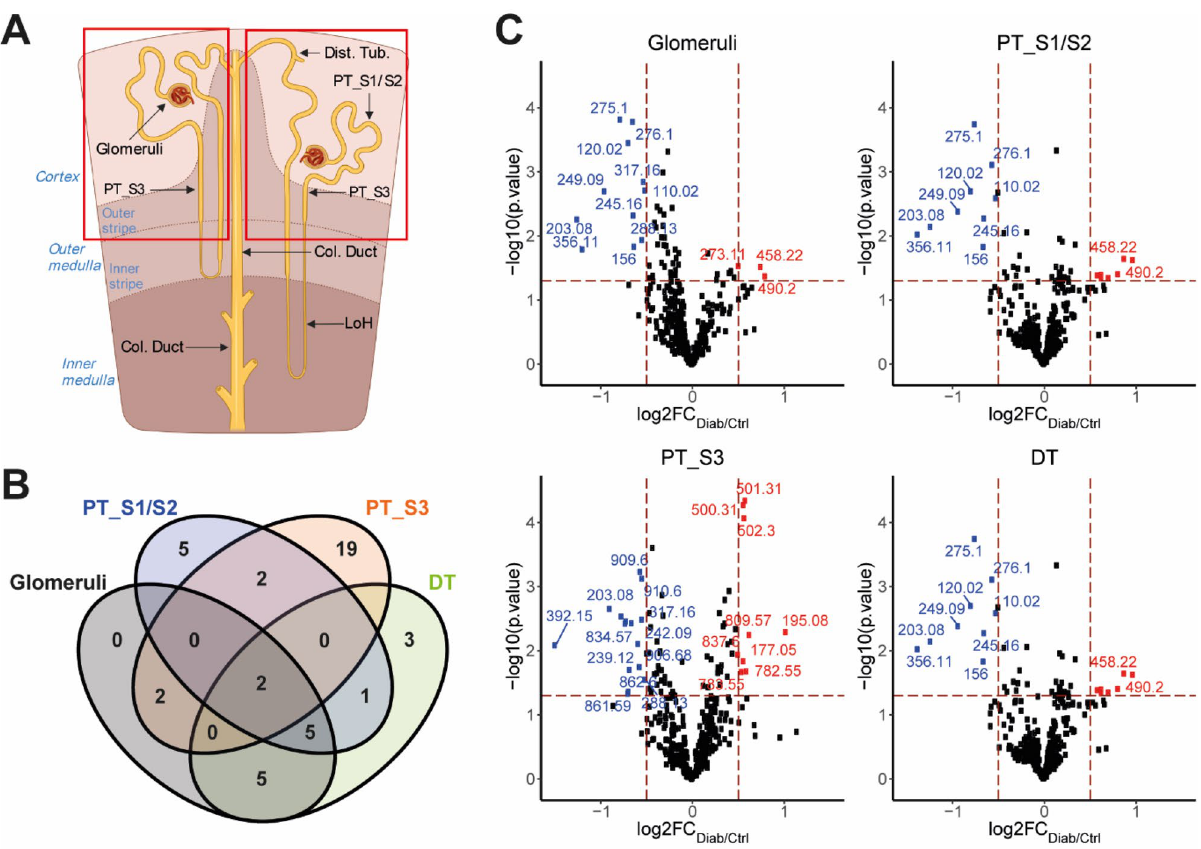
Figure 3. Changes in metabolic profile of specific renal cell types. ( A ) Schematic of a nephron, with the regions of interest for further data interrogation of metabolic characterization highlighted. ( B ) Venn diagram displaying the number of metabolites that are changed with a fold change larger or smaller than 0.5 or -0.5 respectively in the nephron segments. ( C ) Volcano plots of the nephron regions of interest, illustrating the changed metabolites in the glomeruli, PT_S1/S2, PT_S3 and DT of the diabetic mice compared to